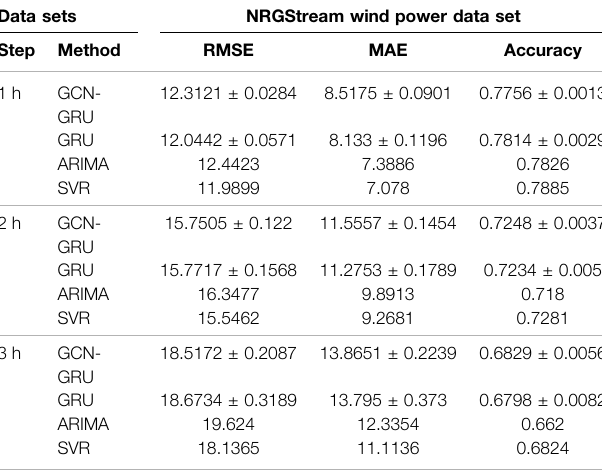
TABLE 6 | The average value of prediction results of all wind stations in NRGStream wind power experiments. Data